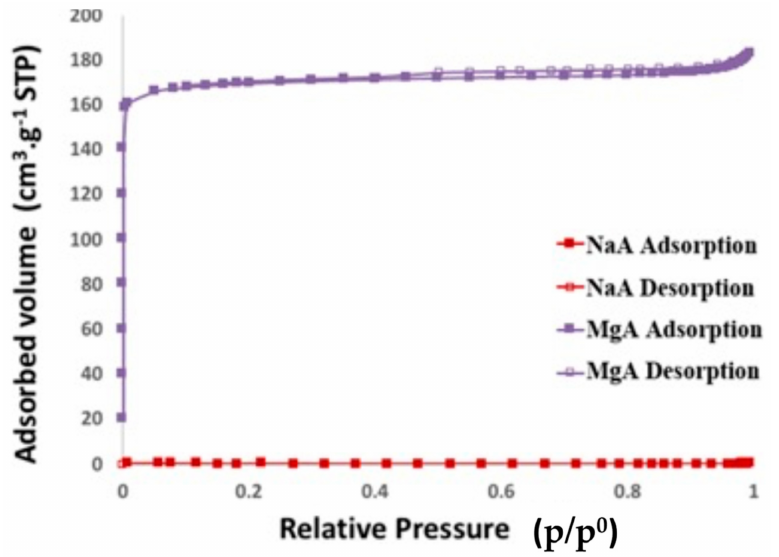
Figure 5. Nitrogen adsorption–desorption isotherms of the raw LTA-type zeolite and its associated magnesium form at − 196 ◦ C.